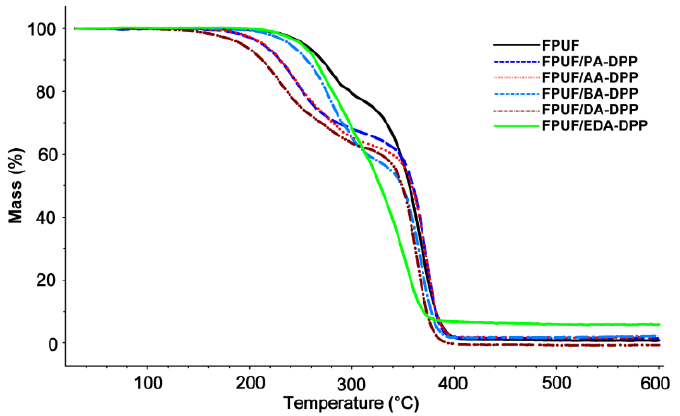
Figure 4. TGA curves of treated FPUF with flame retardant derivatives of DPP compound in comparison to pure FPUF under N 2 atmosphere.